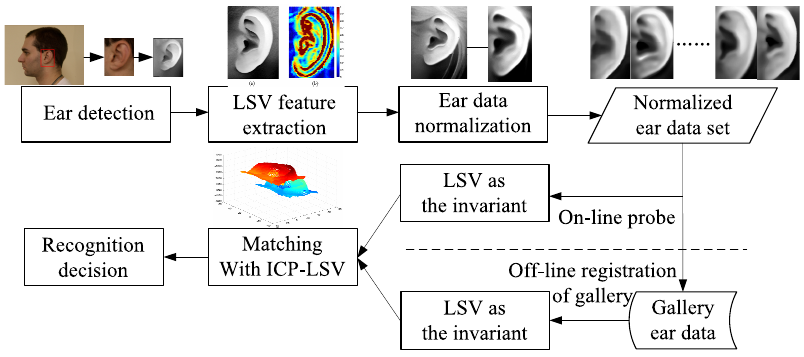
Figure 1. The full automatic 3D ear recognition system. ICP, Iterative Closet Point; LSV, Local Surface Variation.